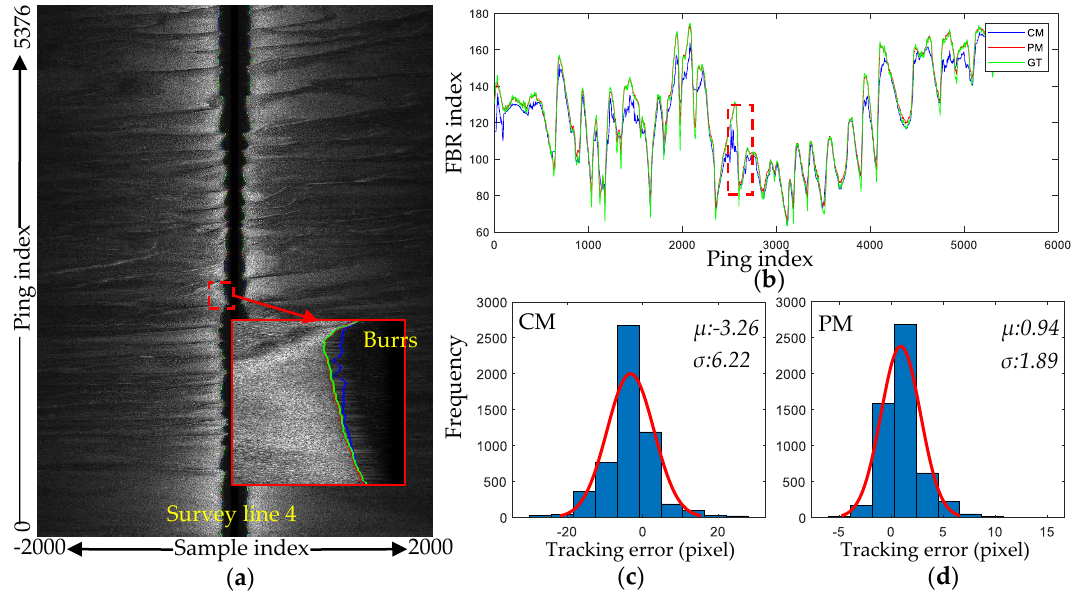
Figure 15. Bottom tracking experiment on the SSS data with drastically changing terrain. ( a ) Waterfall image re-quantized from raw SSS data. ( b ) Averaged bottom tracking results of port and starboard with the tow methods. ( c , d ) Error distribution relative to the manual interpretation.